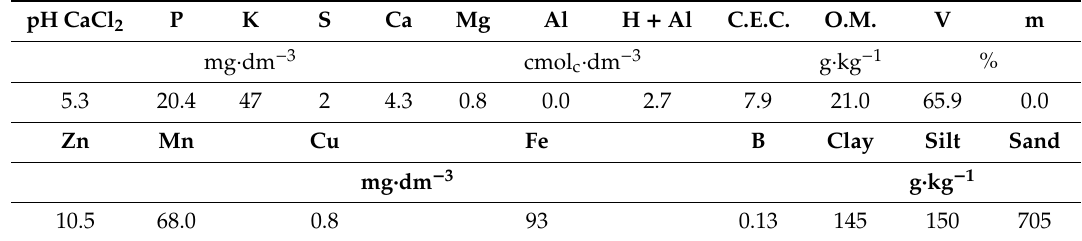
Table 1. Soil chemical and particle size distribution analysis for the sampled